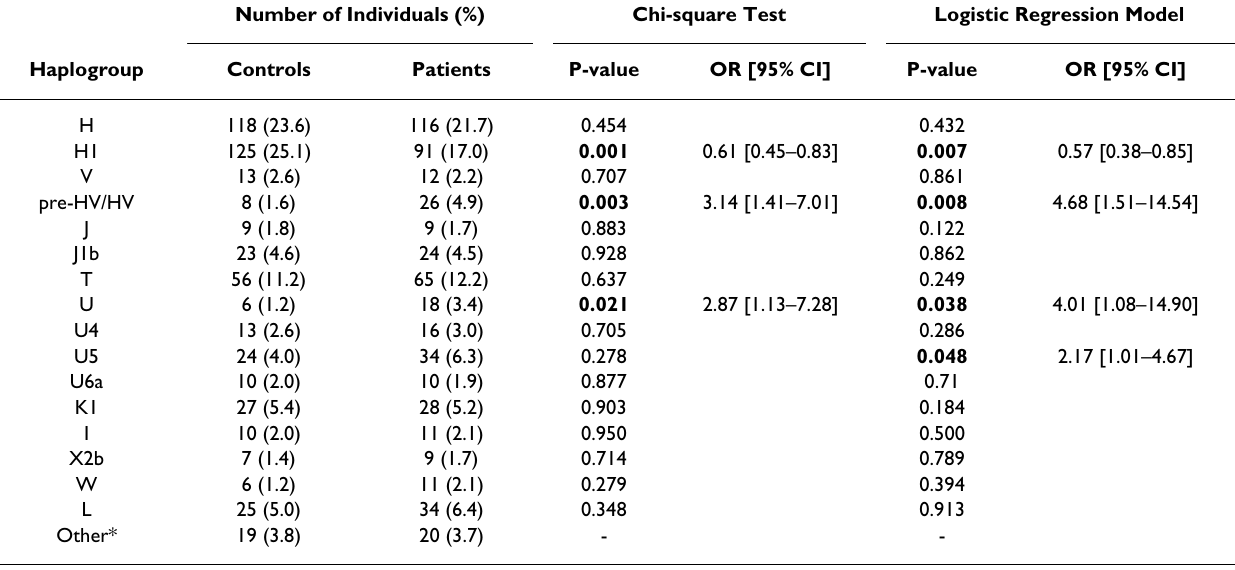
Table 3: Results of mitochondrial haplogroup association testing with ischemic stroke risk. Number of Individuals (%) Chi-square Test Logistic Regression Model